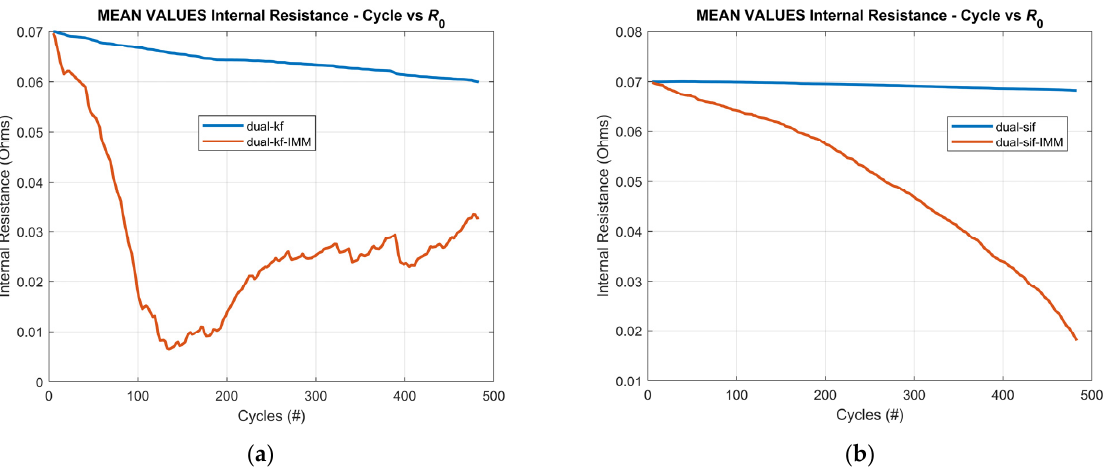
Figure 19. ( a ) Dual-KF and dual-KF-IMM battery capacity estimates. ( b ) Dual-SIF and dual-SIF-IMM battery capacity estimates.